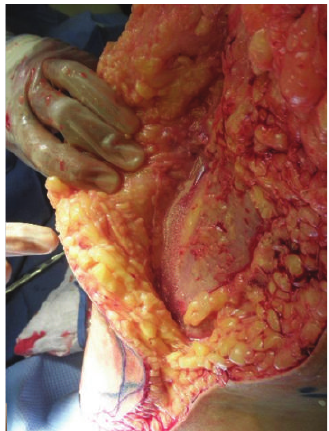
Figure 3: Intraoperative photograph showing deep necrotizing infection involving subcutaneous tissue along superficial and deep facial planes with watery purulent fluid adjacent to deep fascia and underlying muscles.